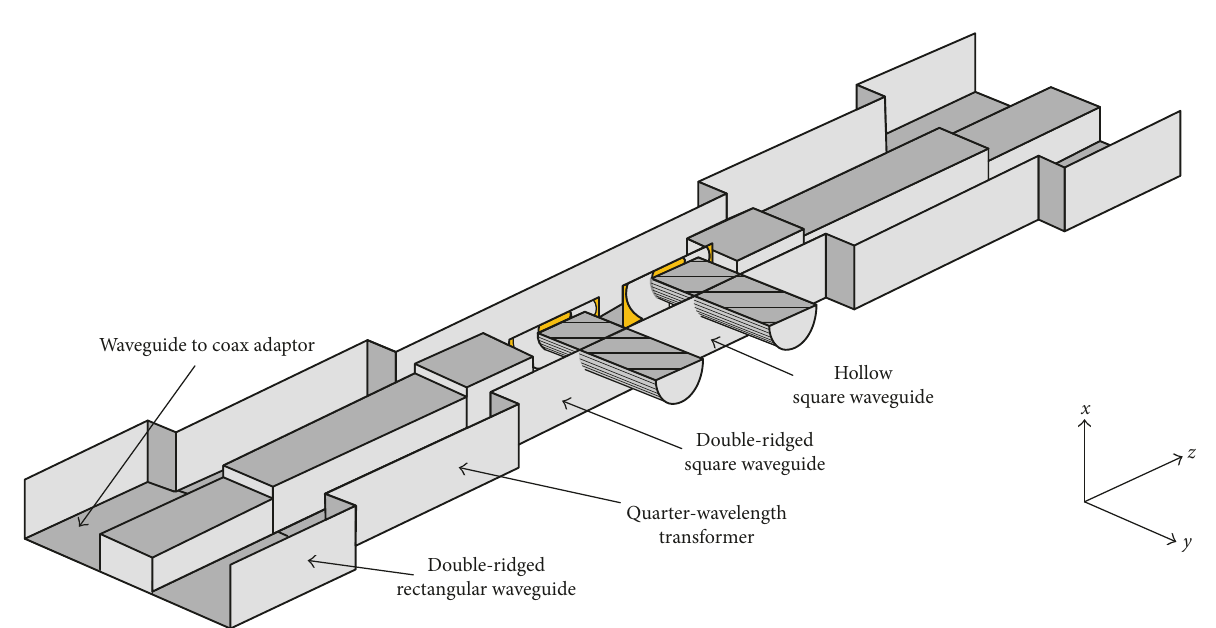
Figure 2: Half-cut structure of the proposed two-pole